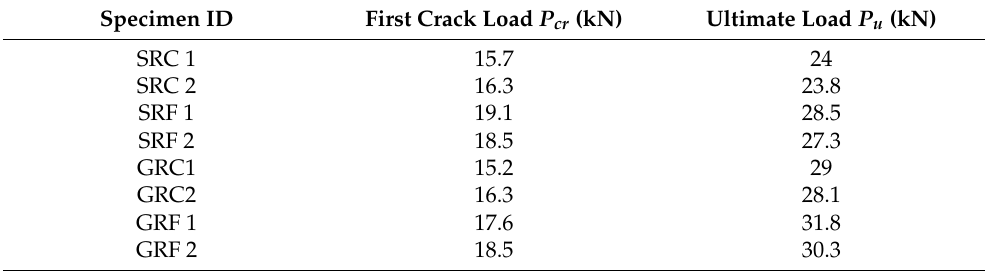
Table 5. First crack load and ultimate load of slab reinforced with steel and GFRP